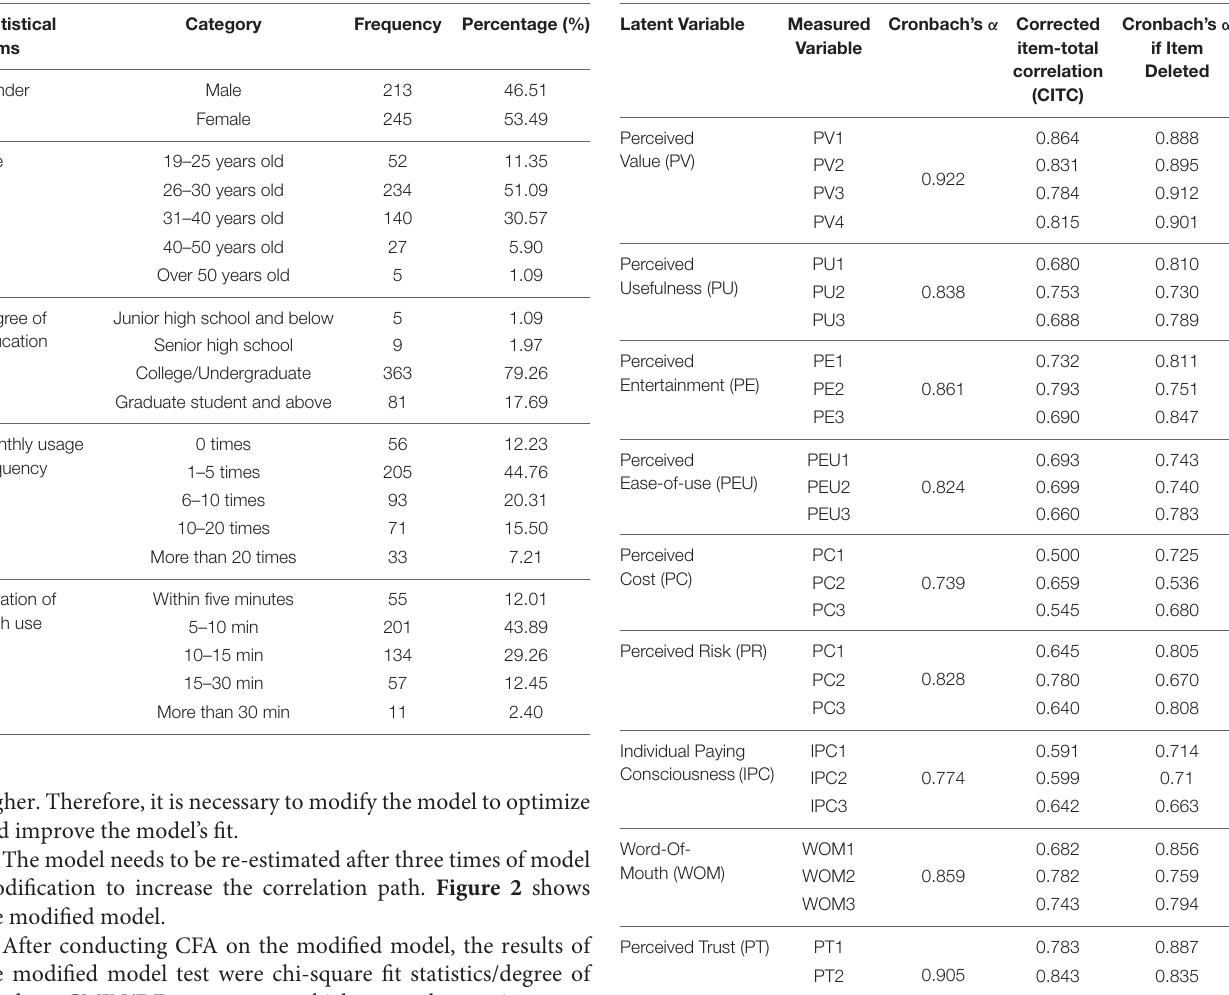
TABLE 2 | Descriptive statistics of sample data. TABLE 3 | Reliability analysis